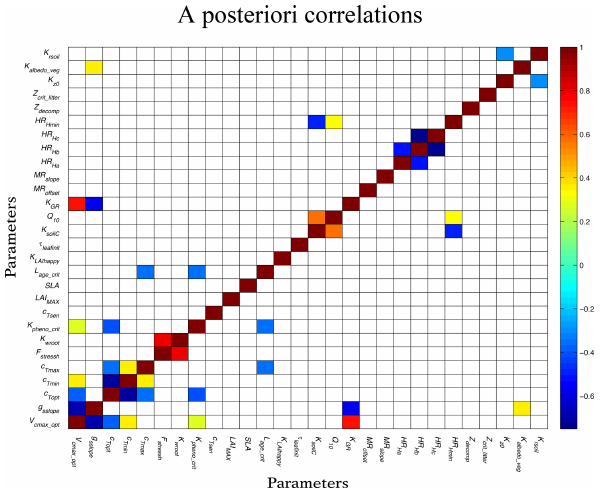
Figure 3. A posteriori correlations between the optimized param- eters corresponding to the best twin BFGS optimization. Red and blue squares are, respectively, related to pairs of parameters that are strongly correlated and anticorrelated. White cells correspond to correlations whose absolute values are lower than 0.1.